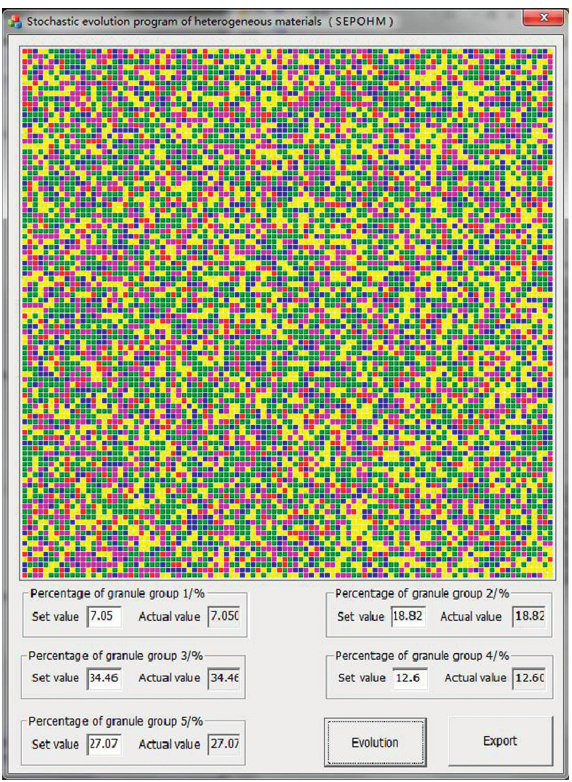
Figure 3: Schematic diagram of software SEPOHM.